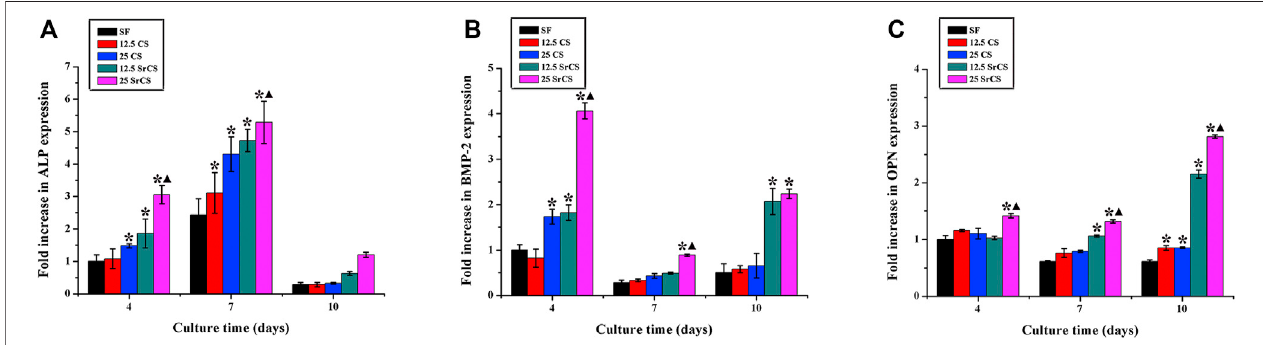
FIGURE 5 | Osteogenic gene expression analysis. The osteogenic gene expression of rBMSCs seeded on different materials (SF: SF, 12.5 CS: 12.5 wt% CS/SF, 25 CS: 25 wt% CS/SF, 12.5 SrCS: 12.5 wt% SrCS/SF, 25 SrCS: 25 wt% SrCS/SF) for 4, 7, and 10 days. (A) ALP; (B) BMP-2; (C) OPN. The SF group was treated as the control group. * p < 0.05 indicates the other groups vs. the SF group, and ▲ p < 0.05 indicates the 25 SrCS group vs. the other groups.